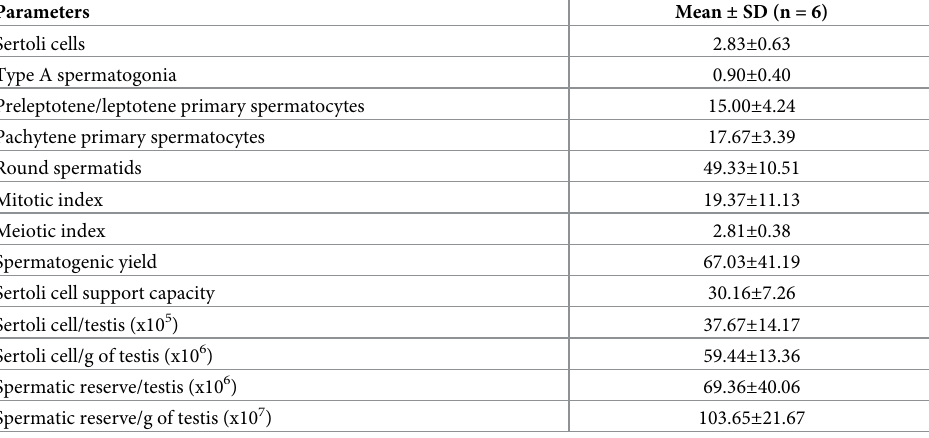
Table 4. Corrected number of germ and Sertoli cells per tubule cross section at stage 1 of the seminiferous epithe- lium cycle (SEC) and spermatogenic indexes of Diphylla ecaudata . The data are reported as mean ± standard devia- tion (SD) of the